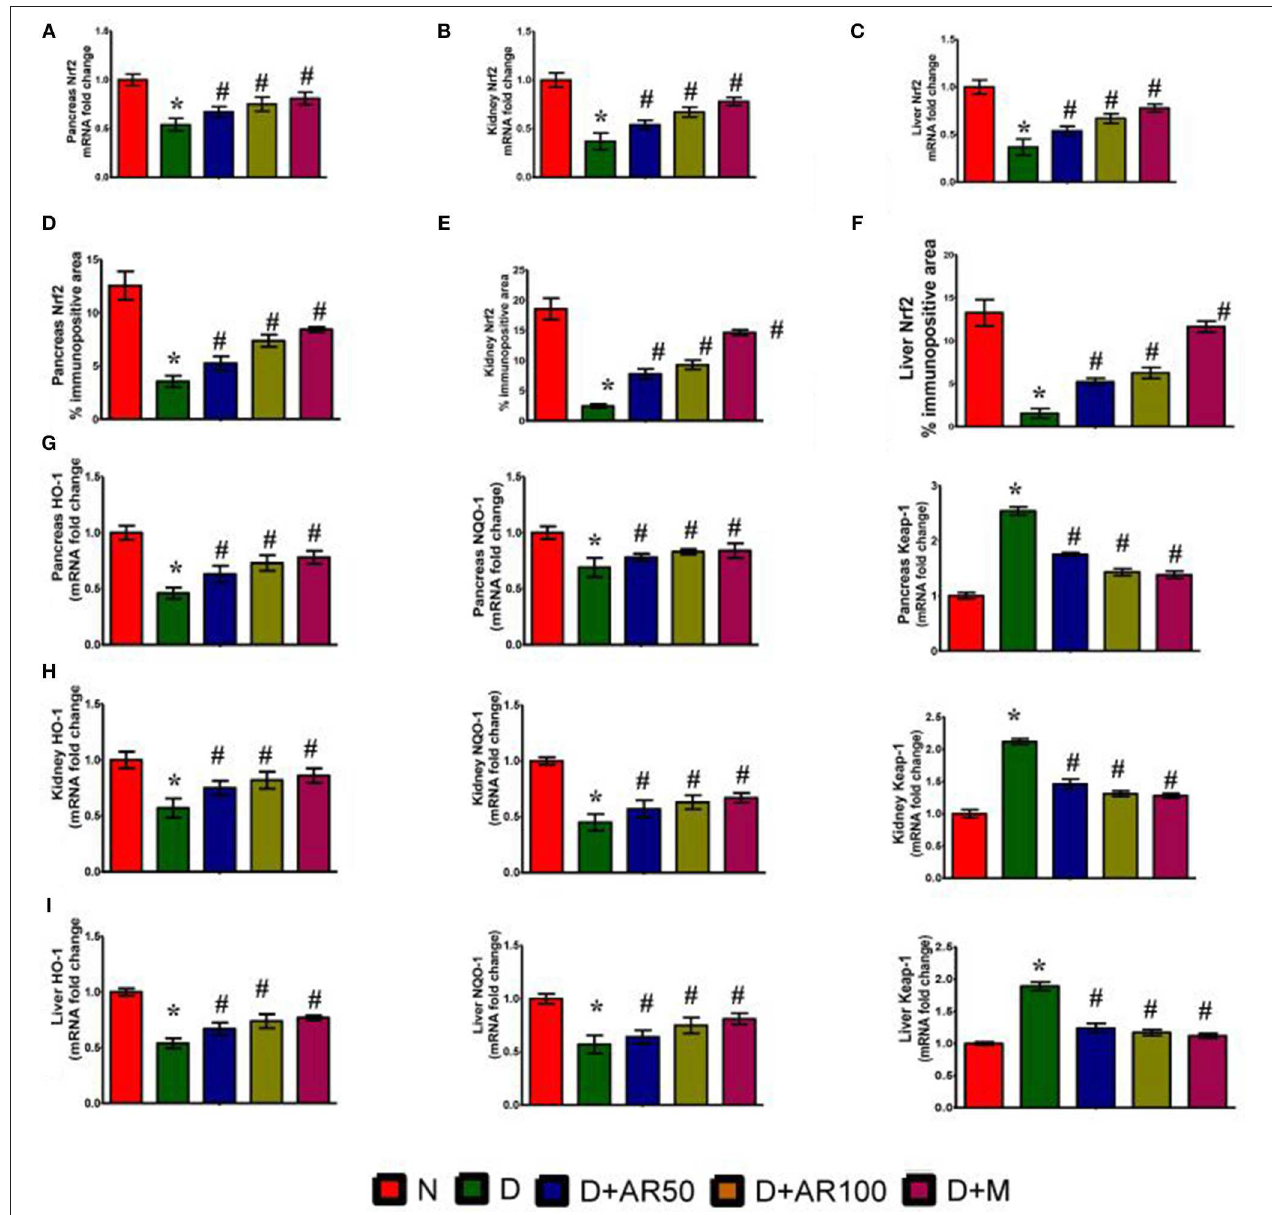
FIGURE 6 | Effect of Annona reticulata L on (A) Pancreas Nrf2 mRNA fold changes (B) Kidney Nrf2 mRNA fold changes (C) Liver Nrf2 mRNA fold changes (D) Pancreas Nrf-2% immunopositive area (E) Kidney Nrf-2% immunopositive area (F) Liver Nrf-2% immunopositive area (G) Pancreas HO-1, NQO-1, and Keap-1 mRNA fold changes (H) Kidney HO-1, NQO-1, and Keap-1 mRNA fold changes and (I) Liver HO-1, NQO-1, and Keap-1 mRNA fold changes. Each value is mean ± SD of six rats in each group.*significant compared to normal control group p < 0.01. # significant compared to diabetic group p < 0.01.